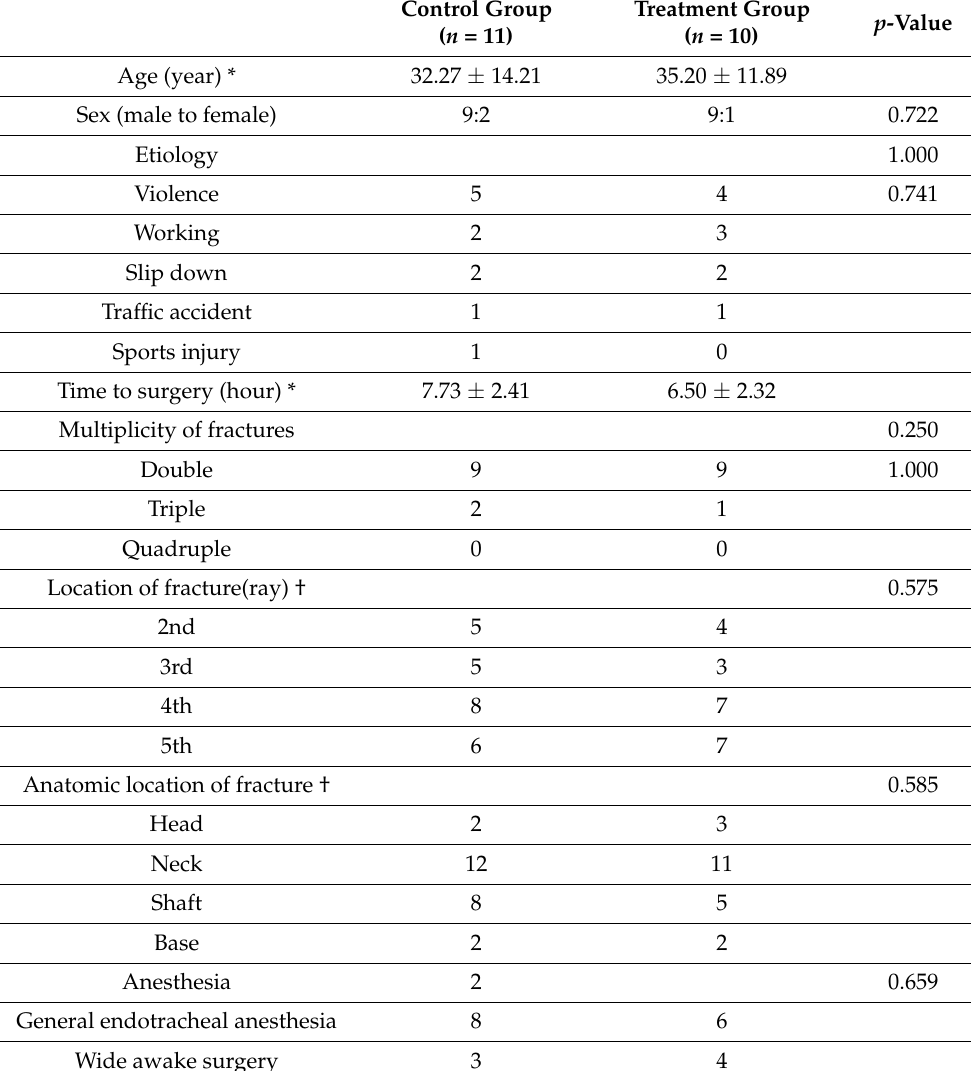
Table 1. Summary of patient